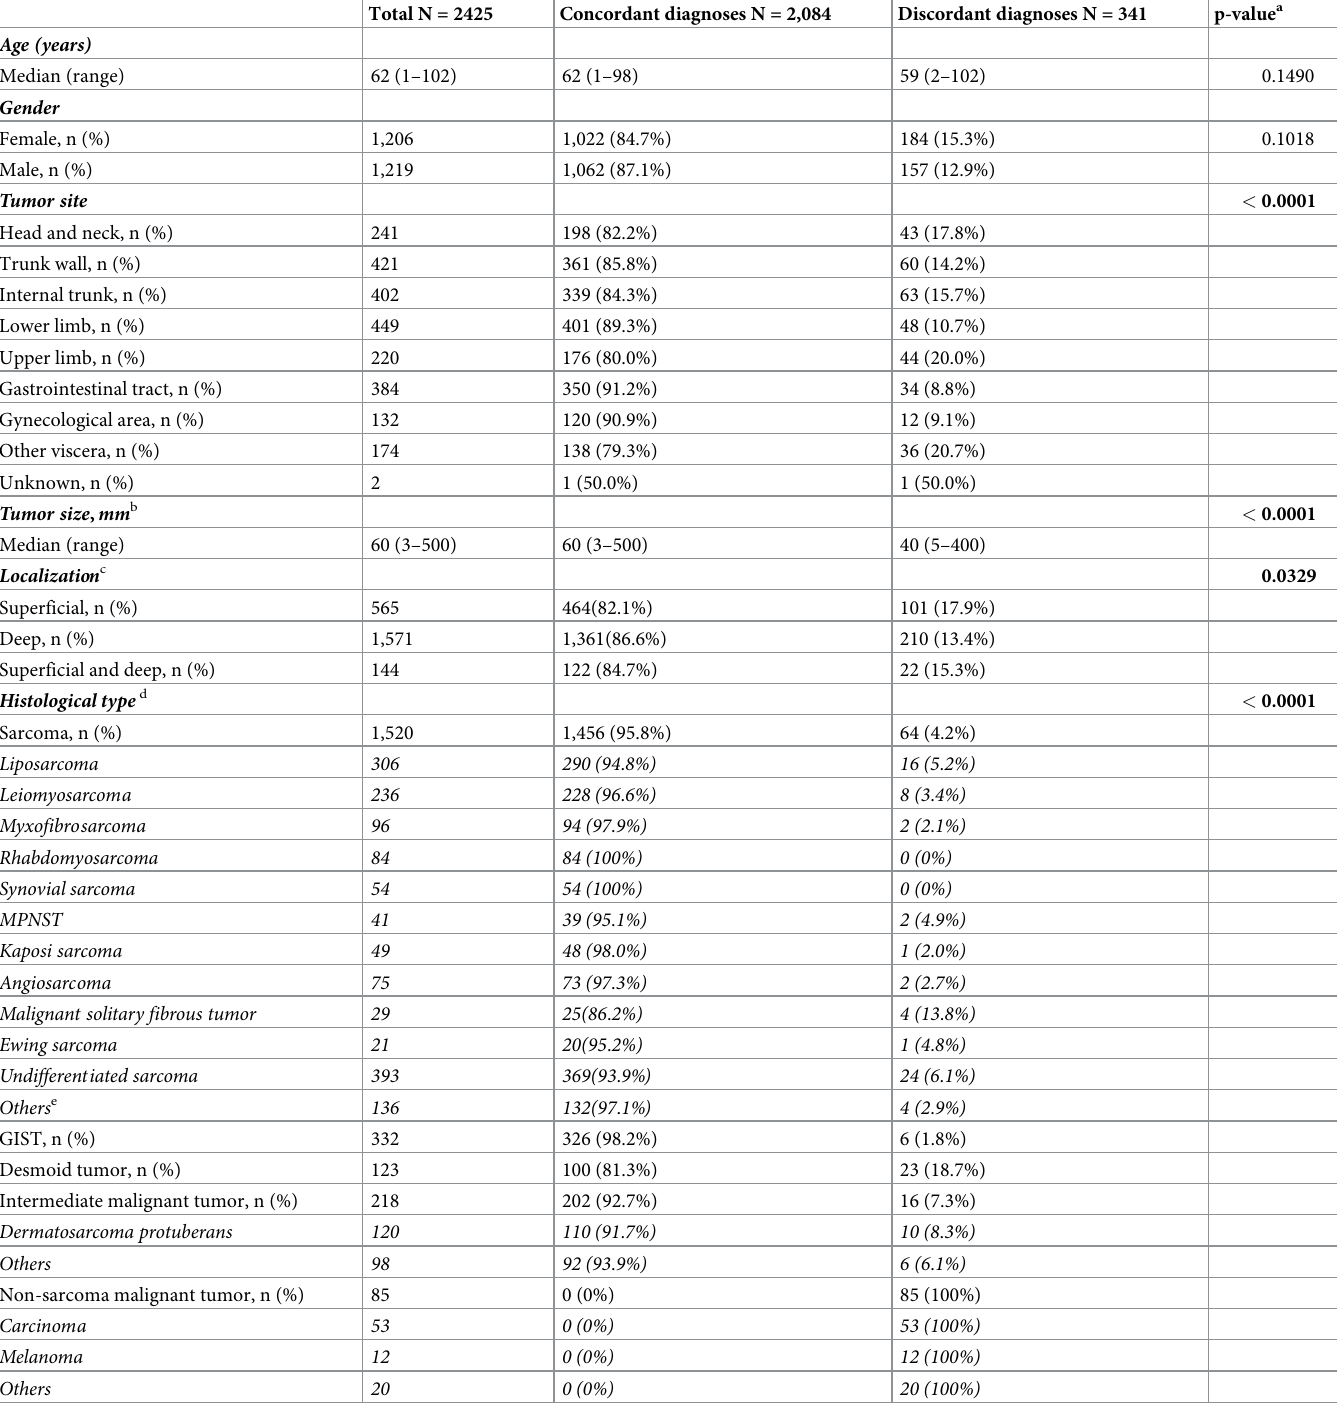
Table 1. Patient